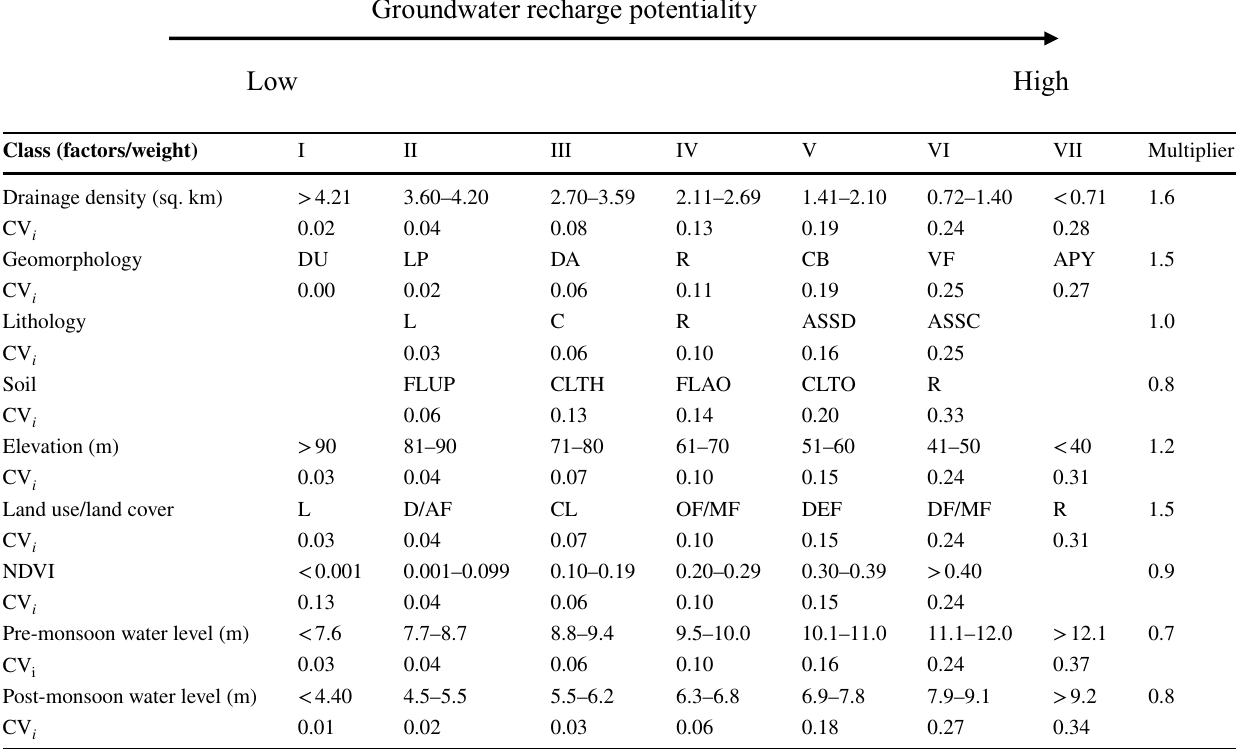
Table 7 The classification of influencing factors on groundwater potentiality